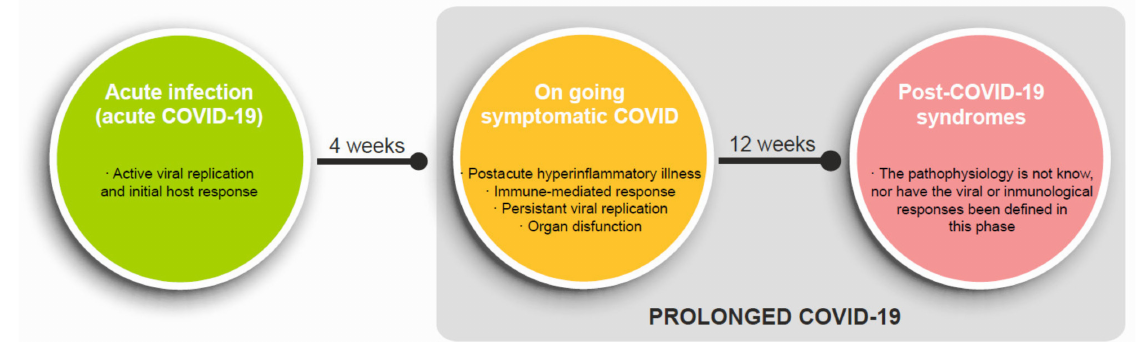
Figure 1. Physiopathology characterization of the different evolutionary phases of SARS-CoV-2 infection to post-COVID- 19